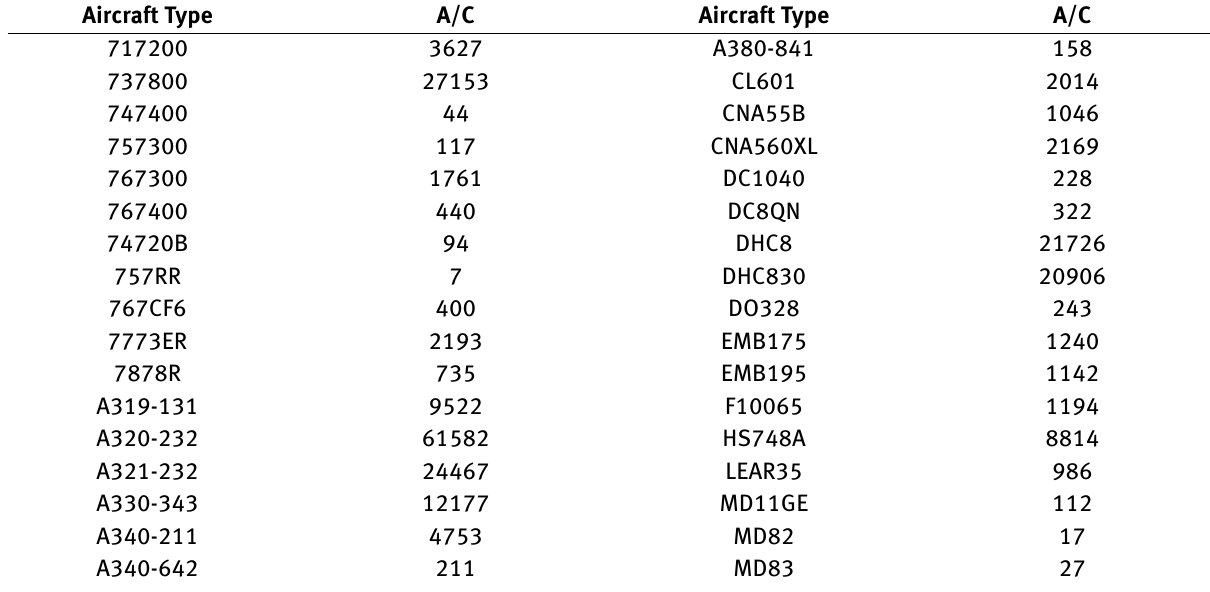
Table 3: Aircraft mix categories at Athens International Airport according to ANP database Aircraft